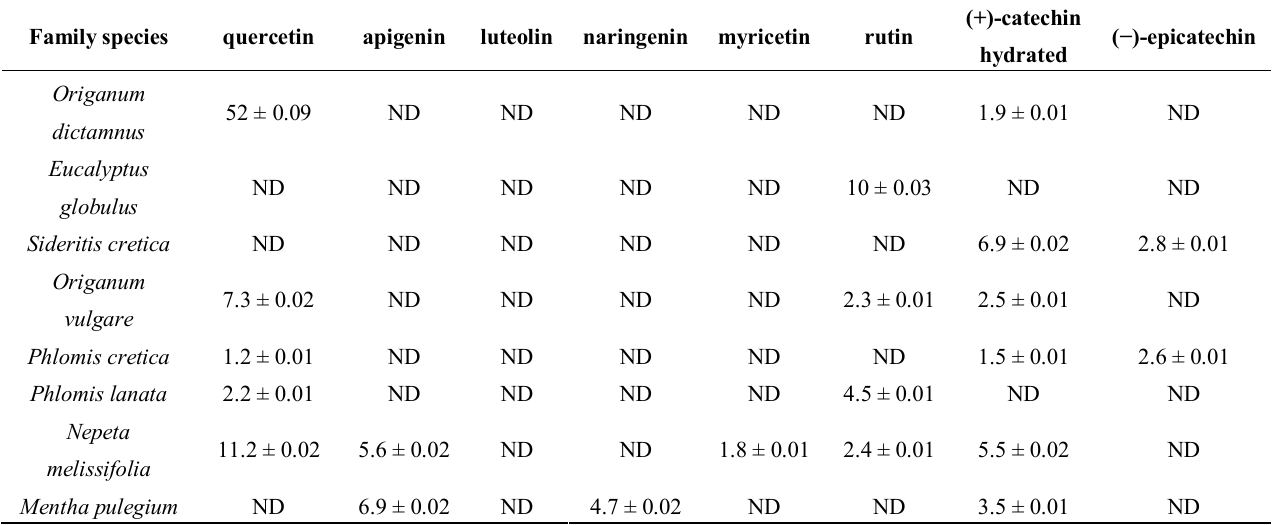
Table 7. Flavonoid content in the examined plant